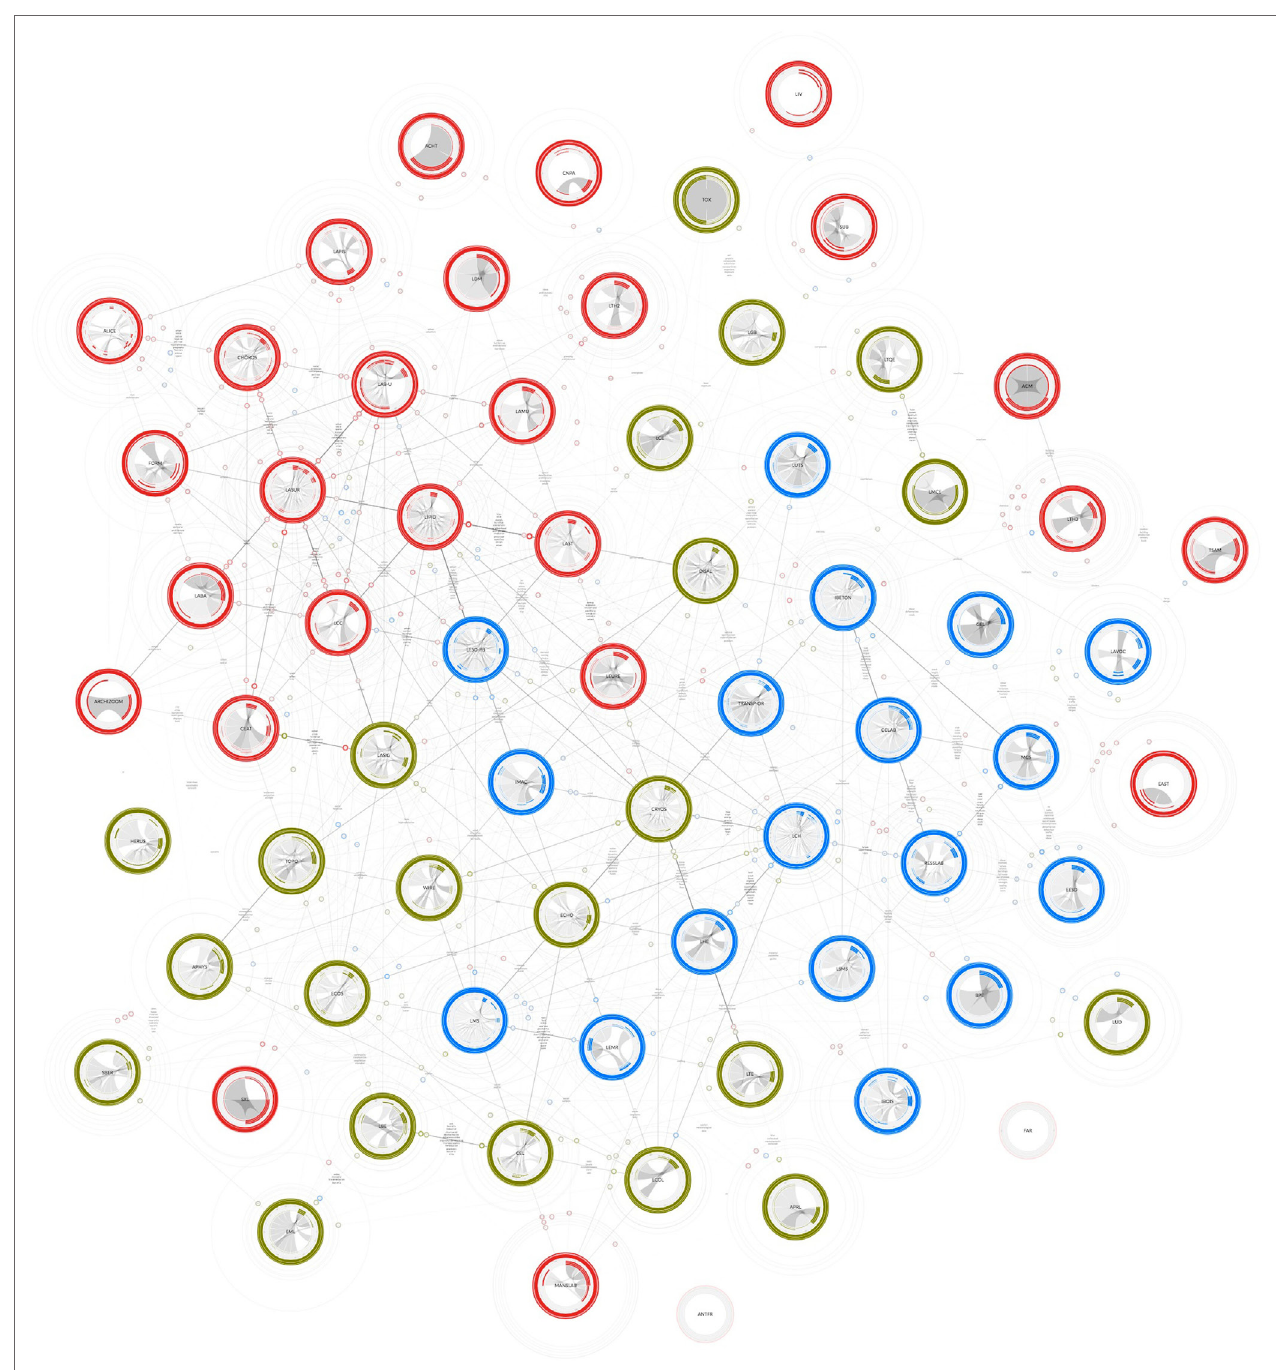
FigUre 1 | The Affinity Map of the School of Architecture, Civil and Environmental Engineering school. The arrangement is the result of three forces (relational, repulsive, and gravitational) applied to each node. The general arrangement shows the closeness of the laboratories according to actual and potential affinities.